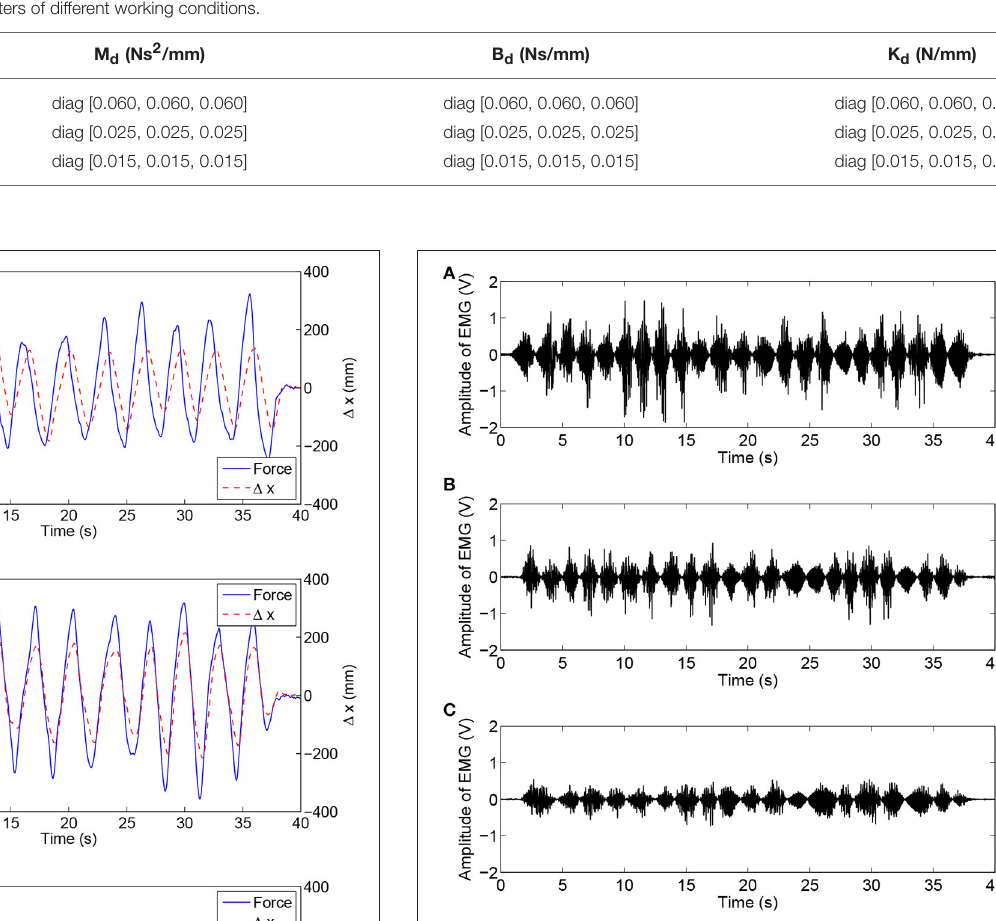
FIGURE 7 | Time histories of EMG activity levels of bicipital muscle during free arm training tests conducted with healthy subject H1 for different